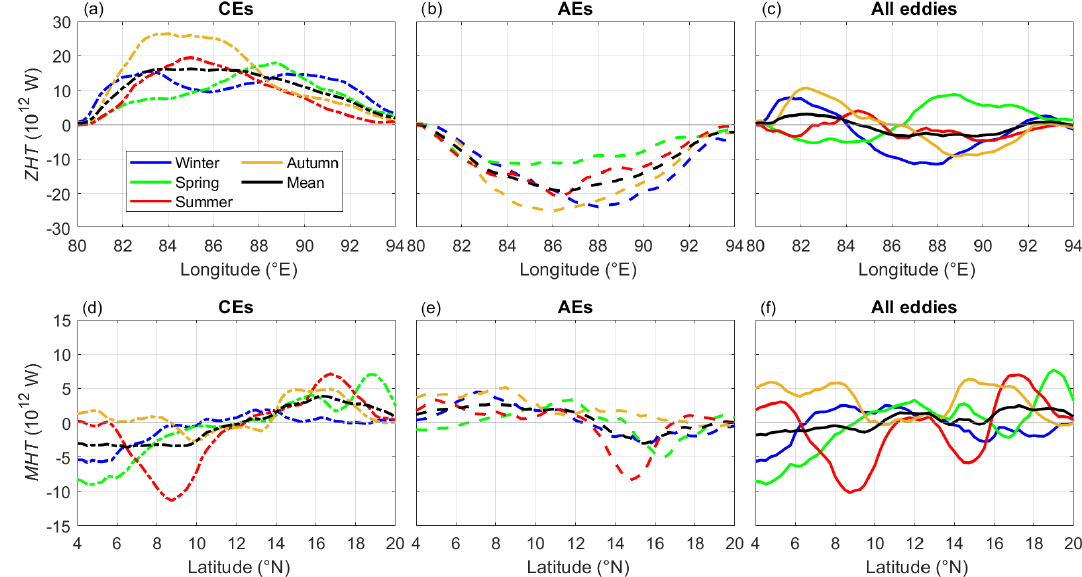
Figure 10. The meridionally integrated zonal heat transport (ZHT, a–c ) at different longitudes and the zonally integrated meridional heat transport (MHT, d–f ) at different latitudes by cyclonic eddies (CEs), anticyclonic eddies (AEs), and all eddies in different seasons in the Bay of